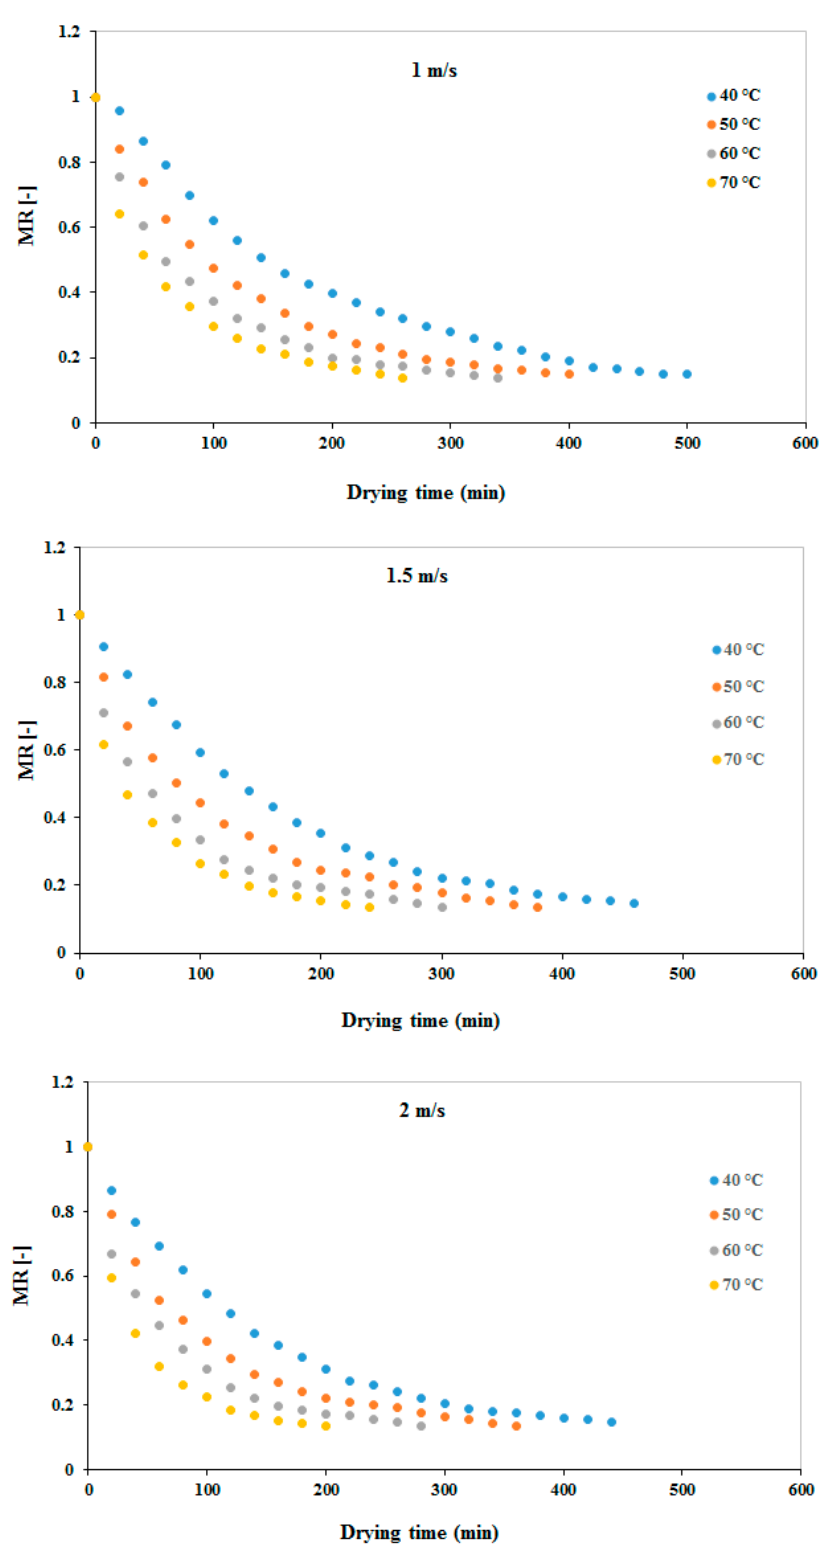
Figure 2. The effect of air temperature on moisture ratio at different air velocities.